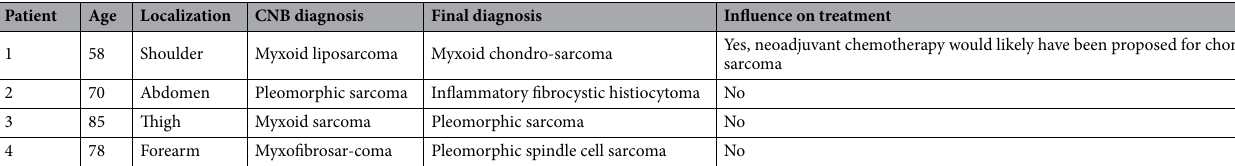
Table 5. In 13 patients, the final diagnosis differed from the core needle biopsy (CNB) diagnosis. In four patients, CNB failed to diagnose malignancy. In two patients, diagnosis of the malignant tumor was achieved, but not the subtype. In four cases, subtype diagnosis was attempted but differed from the definitive diagnosis. The latter four cases are listed here, reflecting whether the incorrect initial diagnosis influenced the treatment. This seems to have been the case in only one patient.